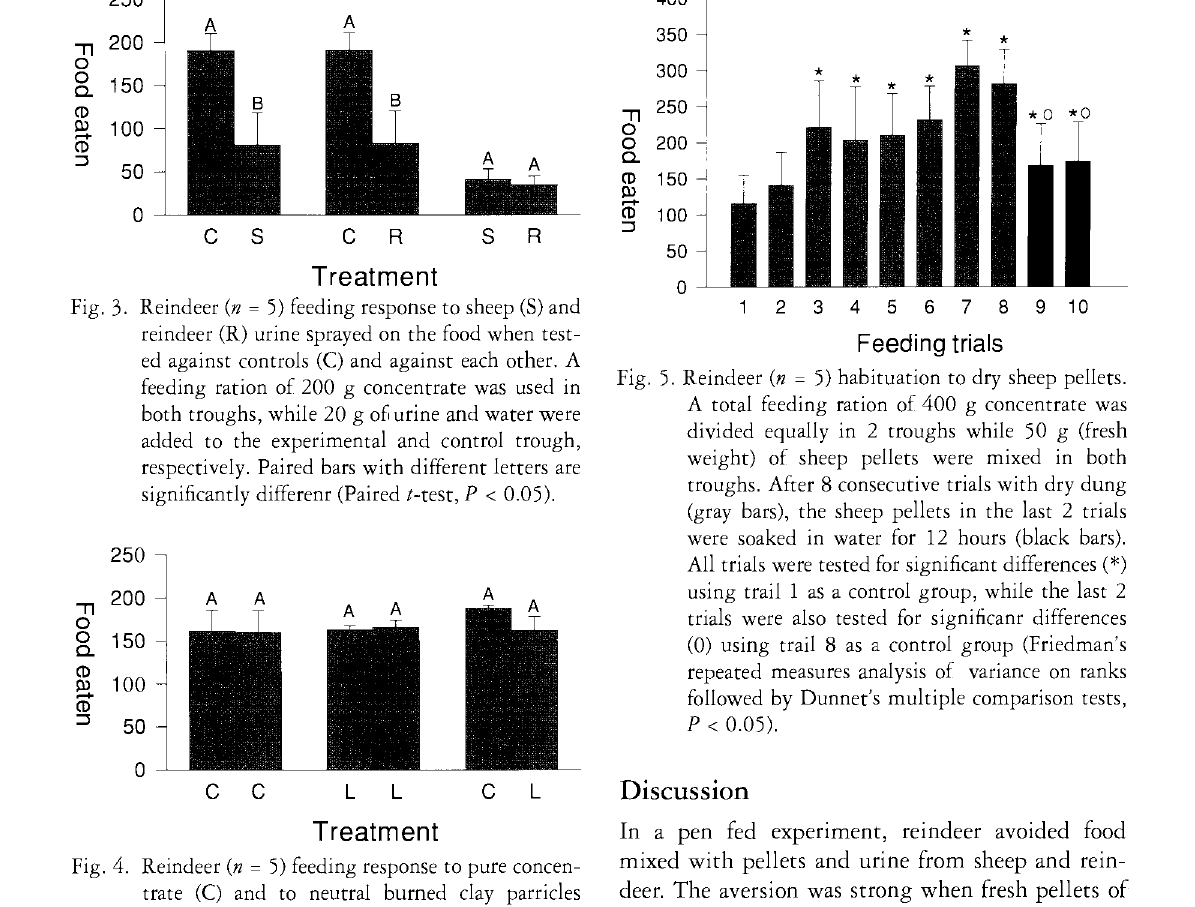
Fig. 4. Reindeer (n = 5) feeding response to pure concen trate (C) and to neutral burned clay parricles "Leca" (L) mixed in food. A feeding ration of 200 g of concentrate was used in both troughs, while 50 g of burned clay particles (approximately the same volume as 50 g fresh sheep and reindeer pel lets) were added in rhe experimental troughs. Paired bars with the same letters are not signifi cantly different (Paired /-test, P > 0.05).